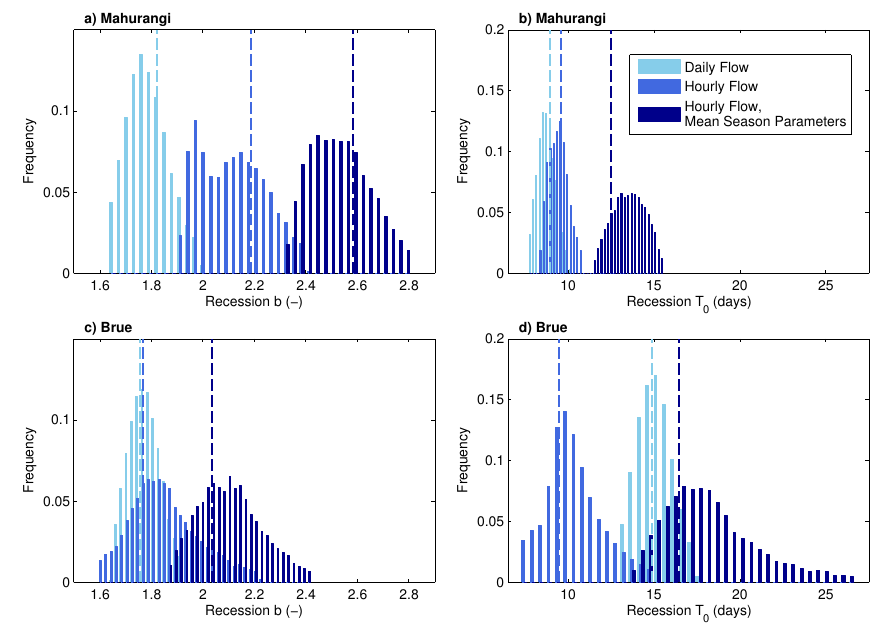
Figure 9. Histograms of recession parameter distributions, where parameters are calculated using (1) daily flow data, (2) hourly flow data, and (3) hourly flow data where recession parameters are calculated per season and then averaged. Dashed lines show the parameter values from the optimal MCMC rating curve. Distributions are truncated at the 2.5 and 97.5